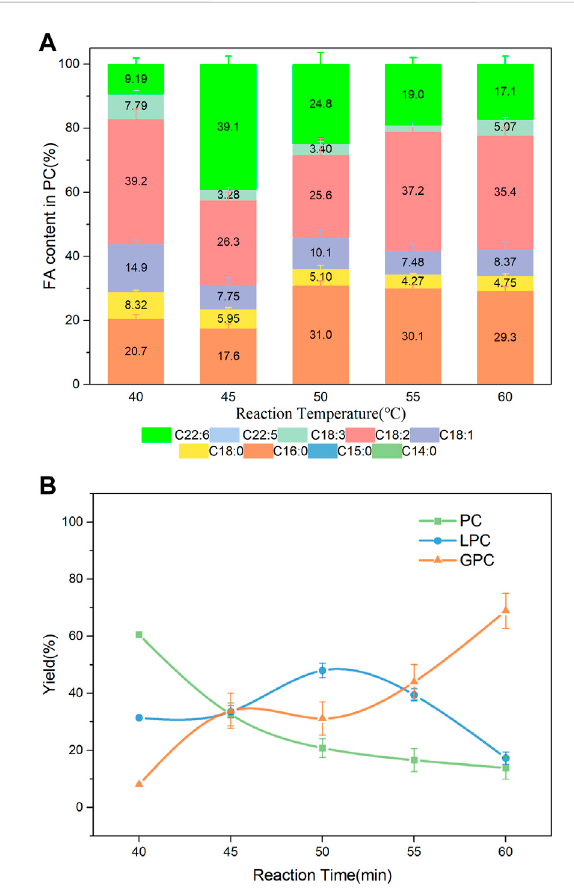
FIGURE 6 (A) Pro fi lesofFAintheproductPC; (B) YieldoftheproductPLsat different temperature; Reaction conditions: 20 mg PC, 1.0 g algae oil, 10 µL PLA1, 500 rpm, 30 min.